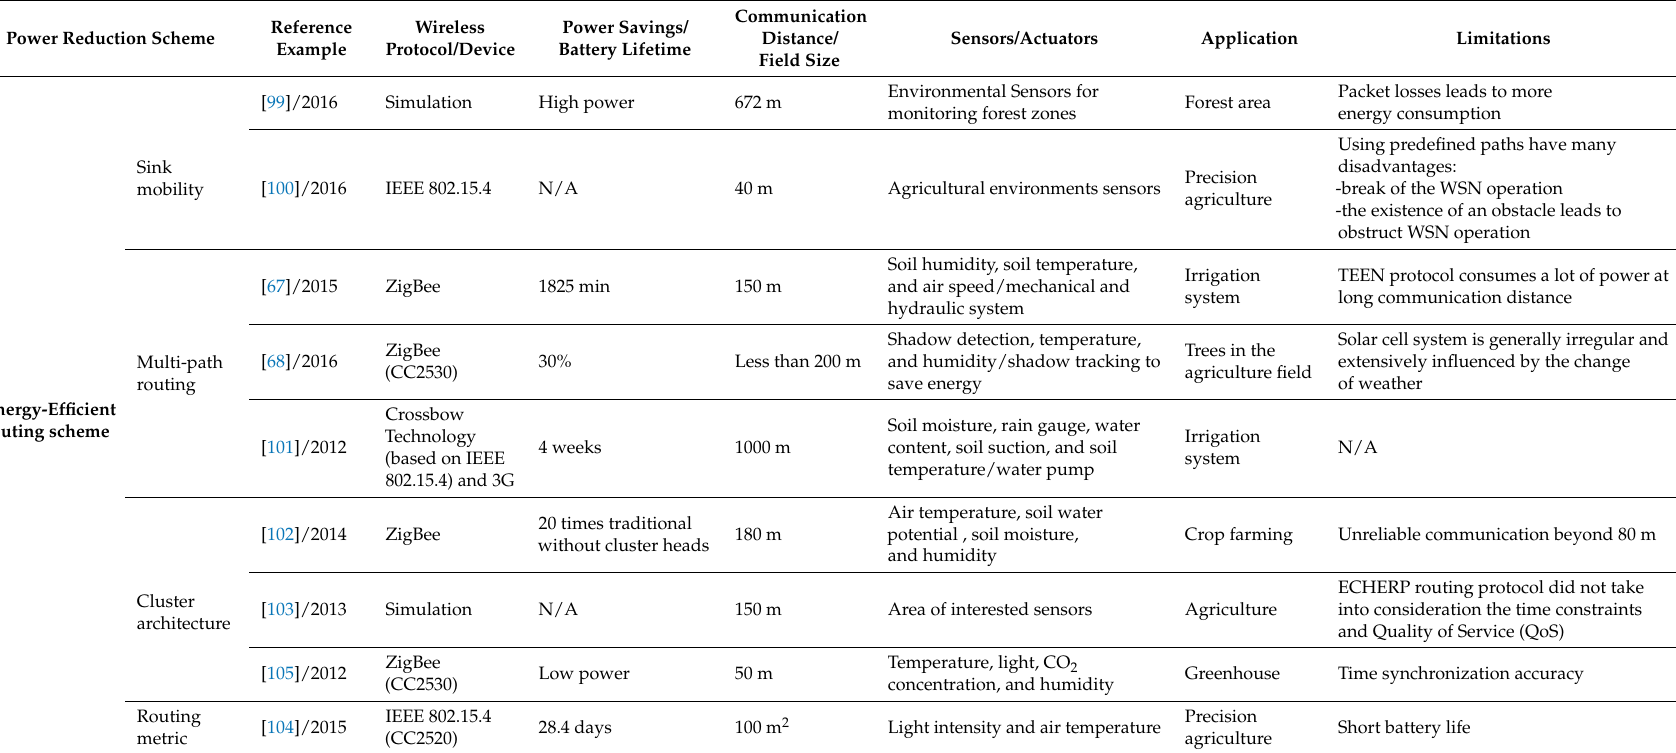
Table 5. Routing protocol schemes for previous research in agricultural